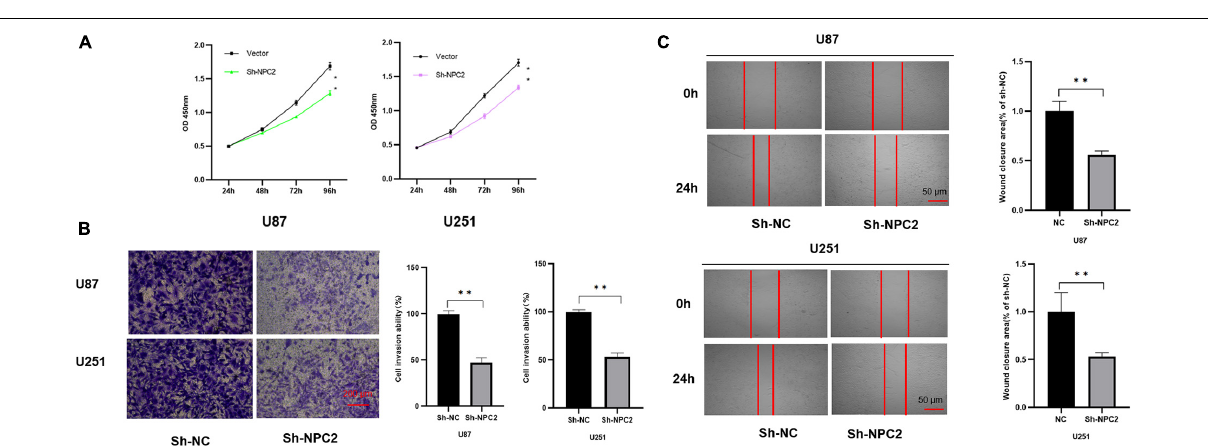
inhibit growth, invasion, and migration abilities of U87-MG and U251 cells in